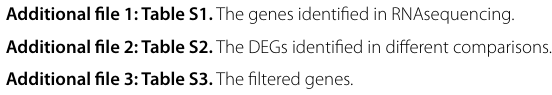
Additional file 2: Table S2. The DEGs identified in different comparisons. Additional file 3: Table S3. The filtered